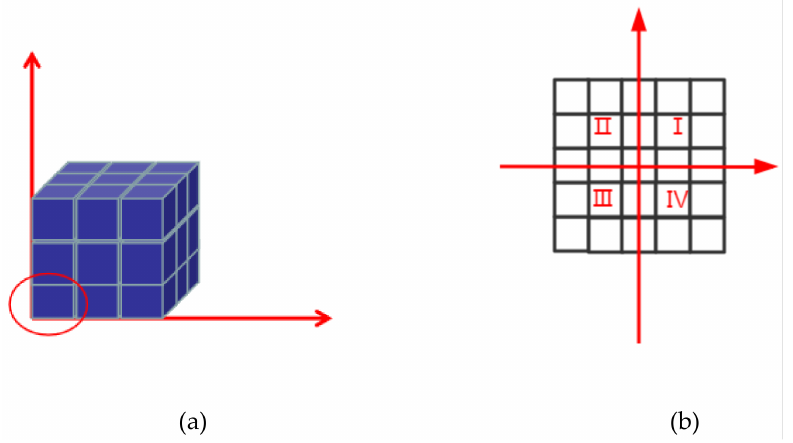
Figure 3. The rod part reserve of pole-like objects based on vertical continuity.